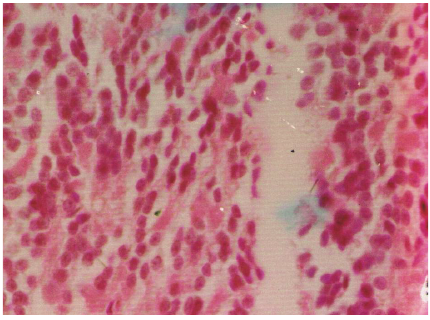
Figure 10: Photomicrograph of cerebellum showing marked distri- bution and atrophy of neuropil architecture. H&E ×